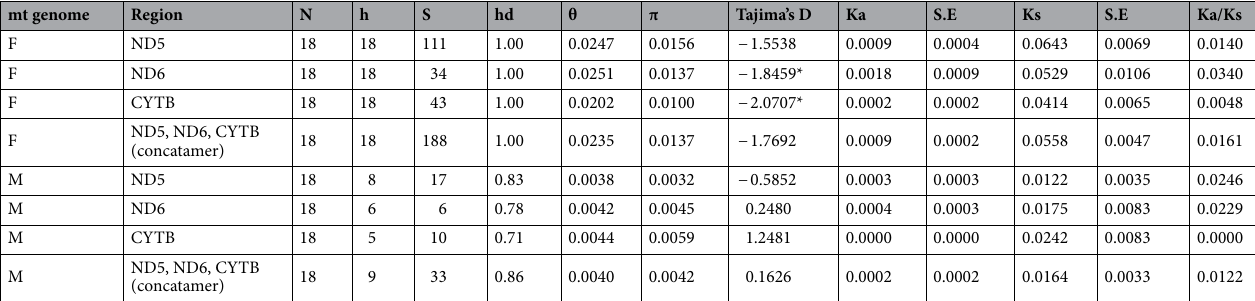
Table 1. Standard indices of genetic diversity in the coding sequences of ND5 (1,317 bp), ND6 (417 bp) and CYTB (663 bp) region and in the concatenated set of ND5, ND6, CYTB sequences for Semimytilus algosus mussel. N—represent the number of individuals, h—the number of identified haplotypes, S—the number of segregating sites, hd—haplotype diversity, θ—number of segregation sites in sample of N DNA sequences, π—nucleotide diversity, Tajima’s D—neutrality test, *—represent statistical significance for p < 0.05, Ka— nonsynonymous substitutions, Ks—synonymous substitutions.